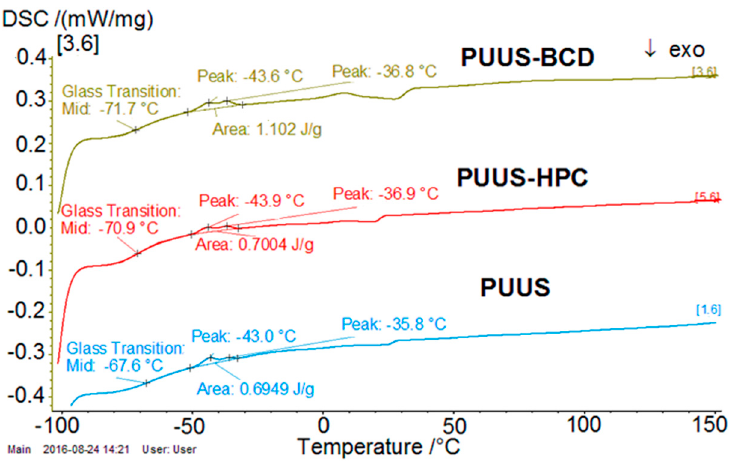
Figure 9. Differential scanning calorimetry (DSC) curves of nanofibrous mat (PUUS) and nanofibrous composite mats (PUUS-HPC and PUUS- β CD).